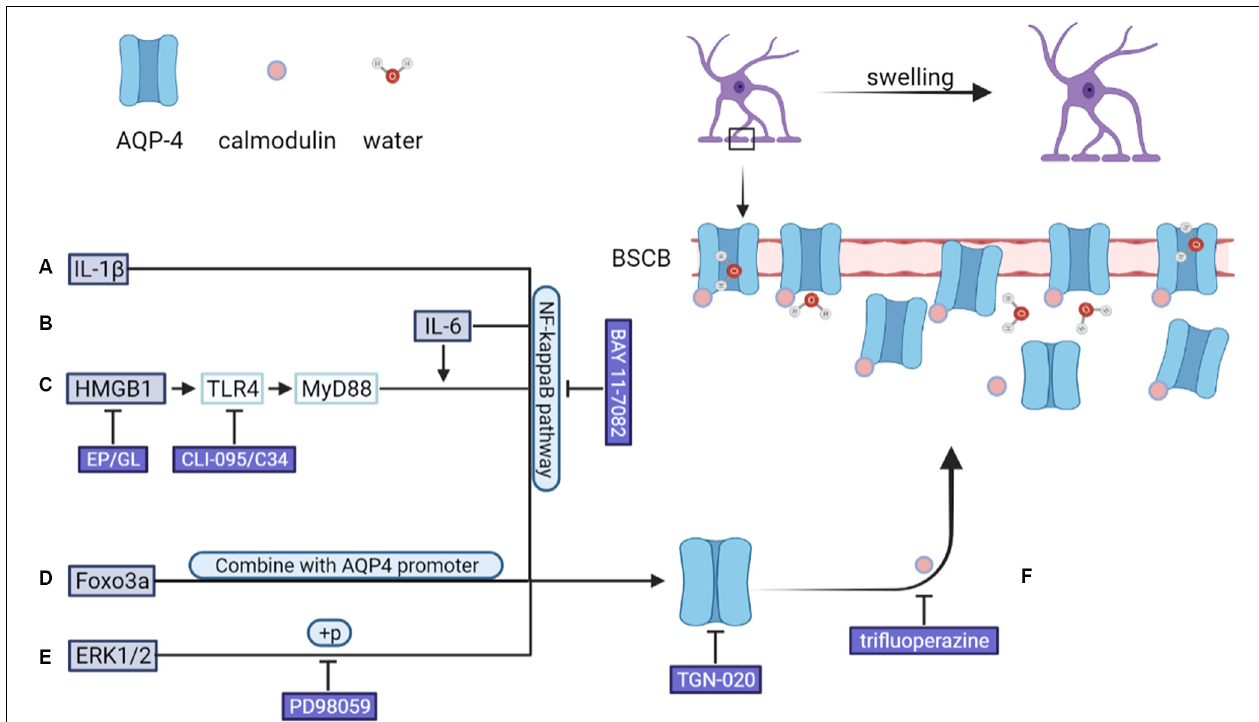
FIGURE 2 | After CNS injury, an increase in the levels of (A) IL-1 β and (B) IL-6 leads to the upregulation of AQP-4 expression through the NF- κ B pathway. (C) HMGB1 upregulates AQP-4 expression via the HMGB1/TLR4/MyD88/NF- κ B axis independently of IL-6. (D) FOXO3A undergoes nuclear translocation, binds to the AQP4 promoter, and upregulates AQP-4 expression. (E) SCI-induced upregulation on of AQP-4 expression was down-regulated by PD98059 (ERK blocking agent) and TGN-020 (aquaporin-4, AQP4, blocking agent). In addition, (F) AQP-4 undergoes a conformational change after binding to calmodulin, after which it localizes to the BSCB, leading to an increase in the amount of water entering astrocytes. ERK, extracellular signal-regulated protein kinase; BSCB, blood–spinal cord barrier.